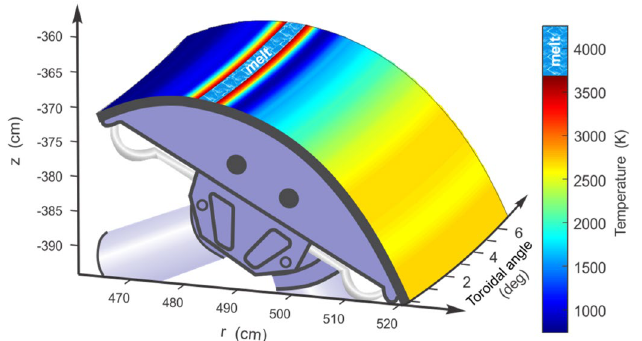
Figure 5. Thermal response of the ITER Dome surface after the 1.0 ms ELM. The images were prepared using OriginPro V2020 and CorelDRAW Graphics Suite 11.